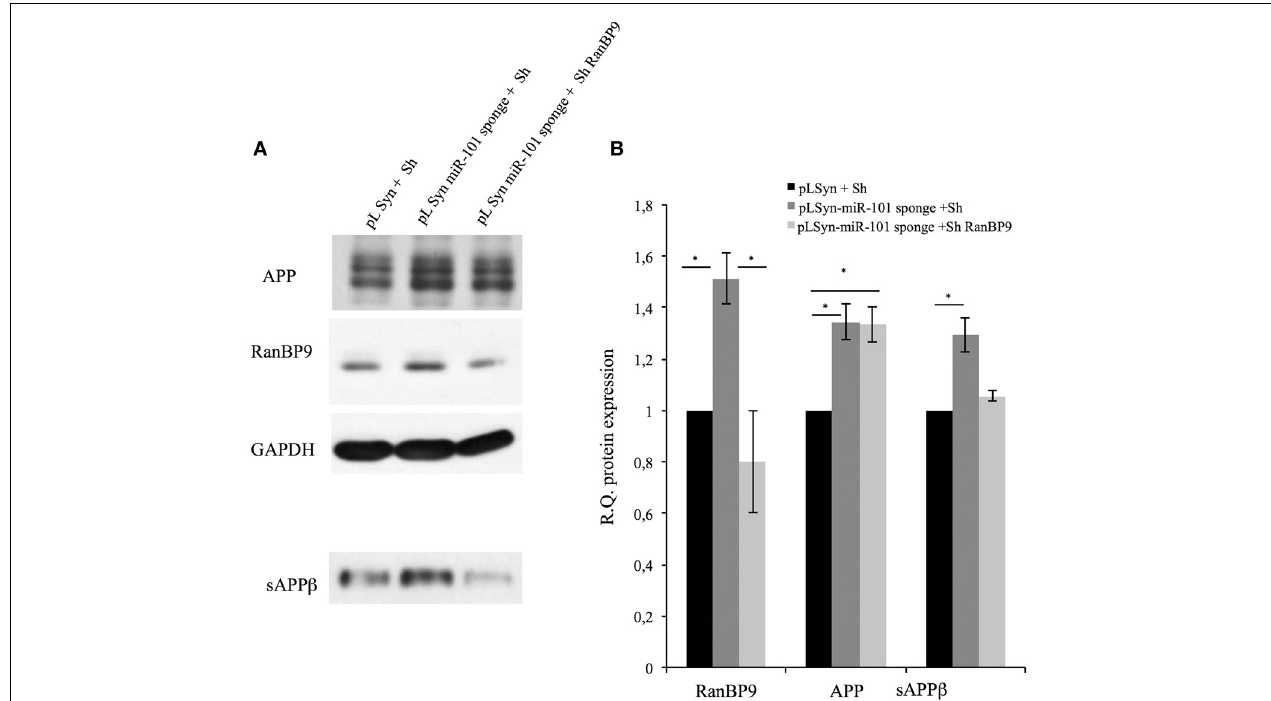
FIGURE 4 | Silencing of RanBP9 reverses oversecretion of sAPP β into the conditioned medium of pLSyn-miR-101-containing hippocampal neurons. Hippocampal neurons at 7 days in vitro were infected with the control pLSyn vector or the pLSyn-miR-101 sponge vector. Seventy-two hours later, the cells were transduced with a lentiviral vector containing RanBP9 siRNA under the control of the U6 promoter, or with a control lentivirus expressing a scrambled siRNA. After 14 days, the neurons were collected for Western blot analysis. (A) Representative immunoblots of protein extracts from lentiviral vector-transduced neurons reacted with